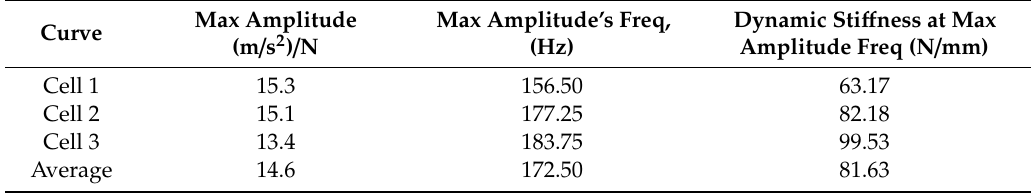
Table 2. Frequency response function (FRF) analysis of new